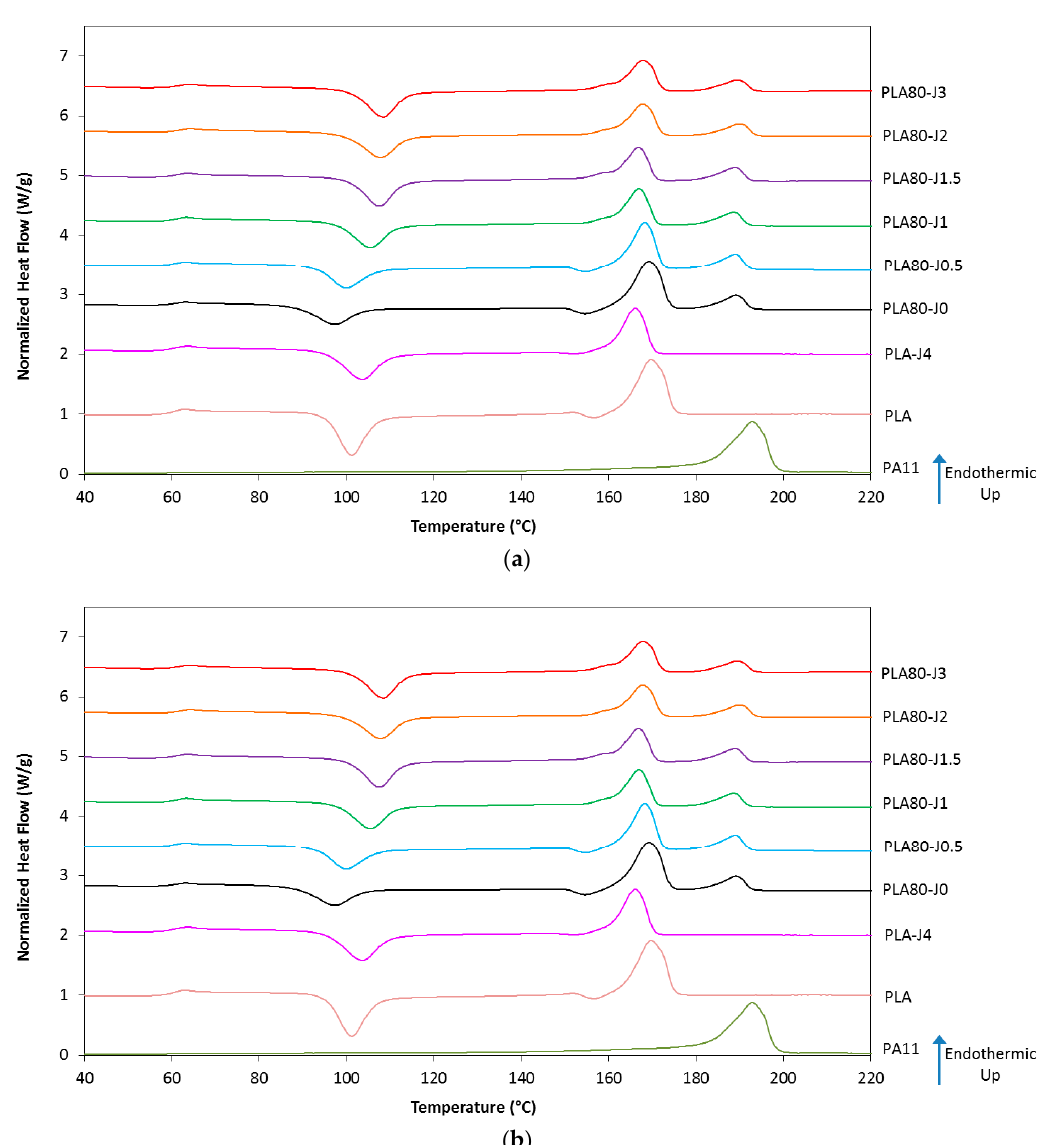
Figure 4. DSC thermograms of the second heating of neat polymers ( a ) and PLA80-Jx blends ( b ).